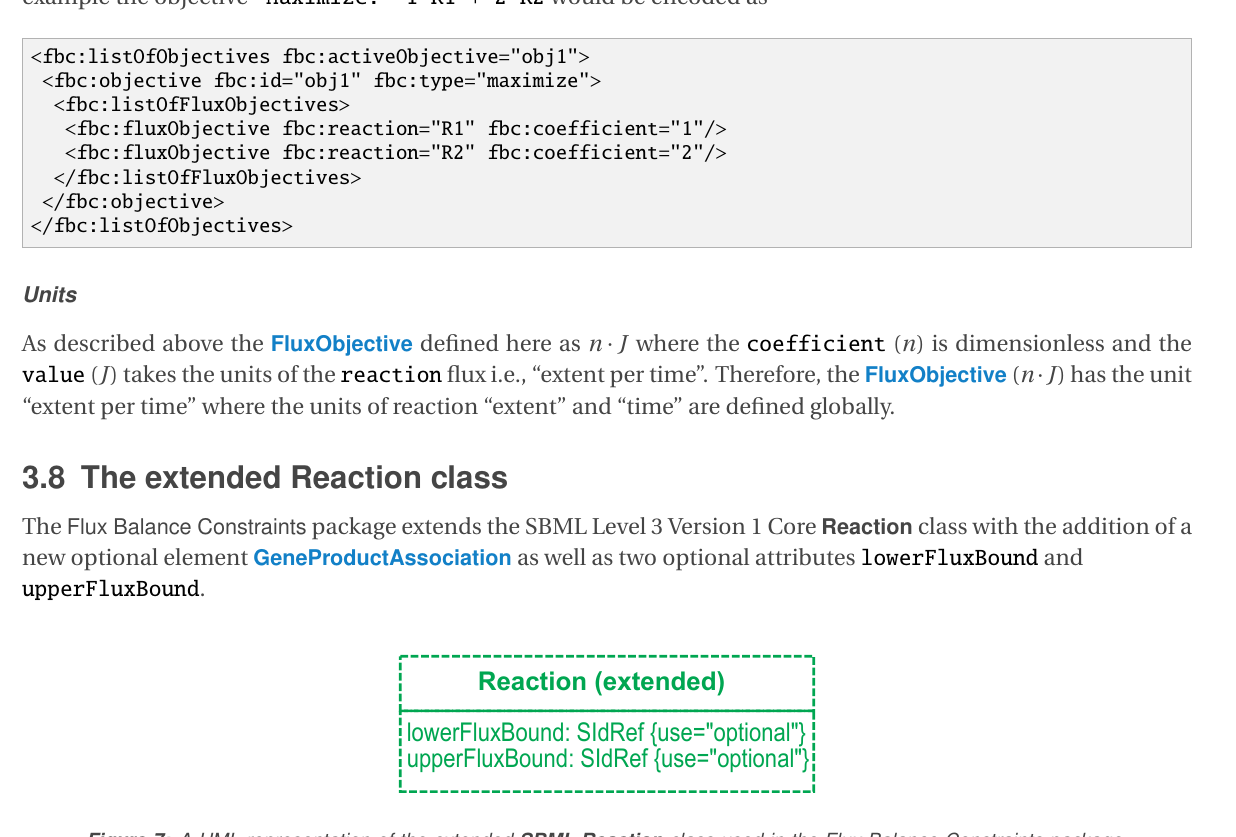
The attributes lowerFluxBound and upperFluxBound